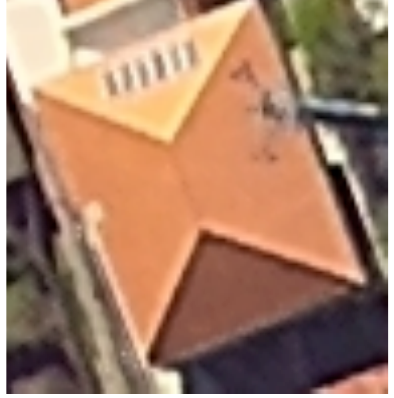
Figure 3. Test building 2